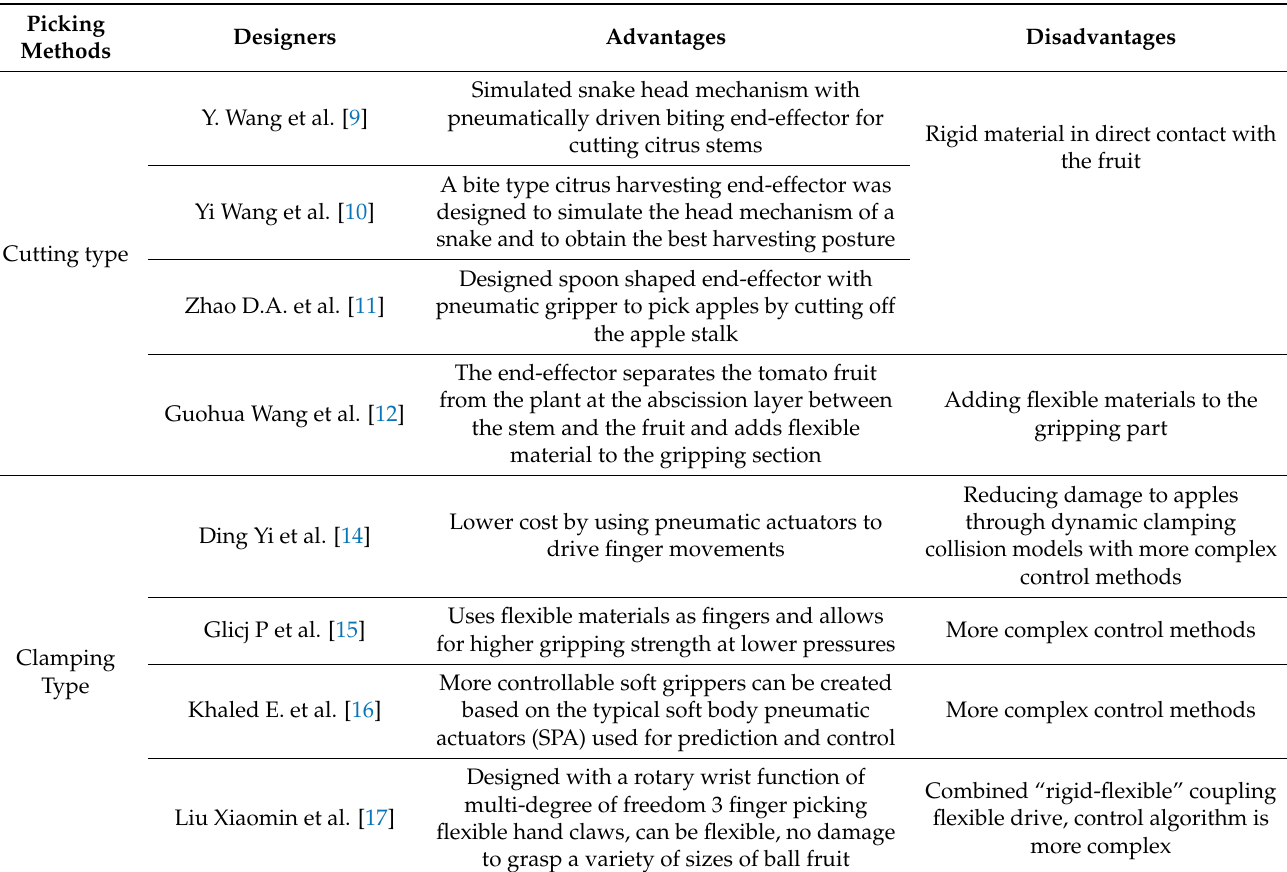
Table 1. The characteristics of mechanical